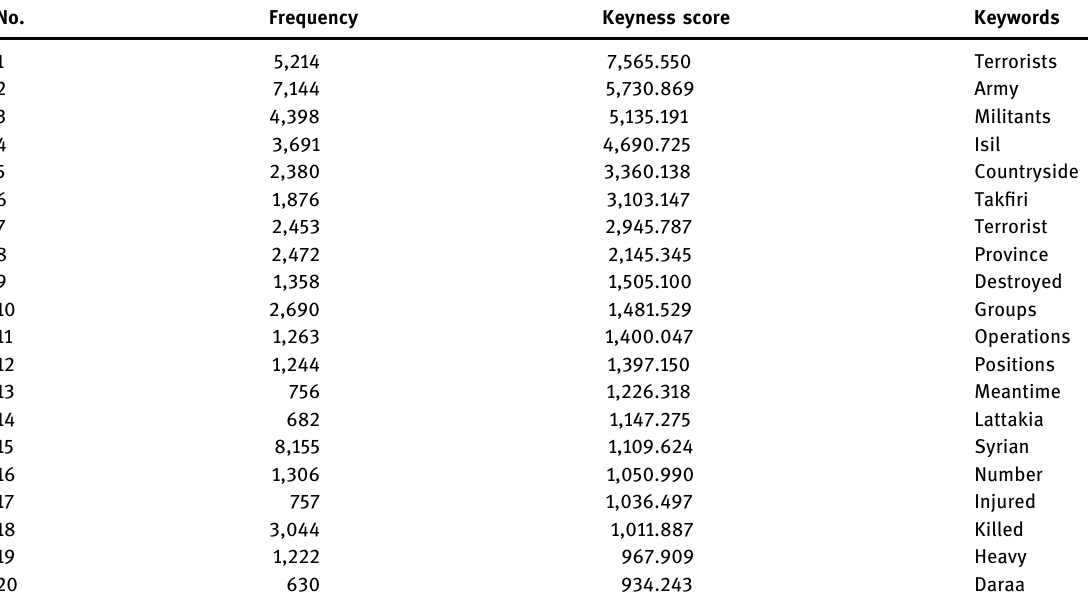
Table 1: Top 20 keywords in